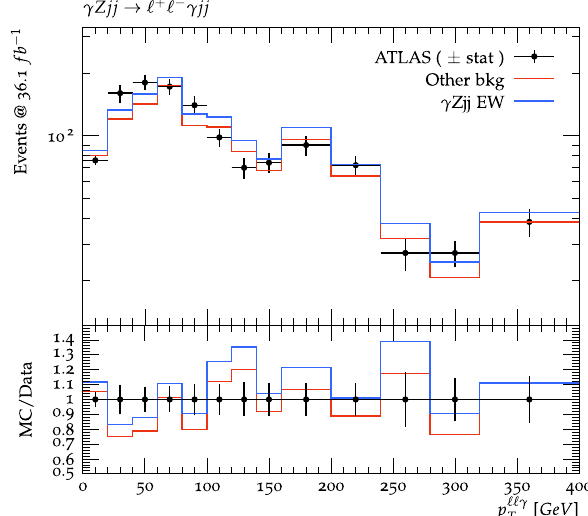
Fig. 6 The CMS detector-level VBS measurement in the Z Zjj final state based on the full Run II luminosity [19]. Here we compare the number of events per m ZZ bin between the theoretical predictions and the experimental data. The error bars display only the statistical uncer- tainty